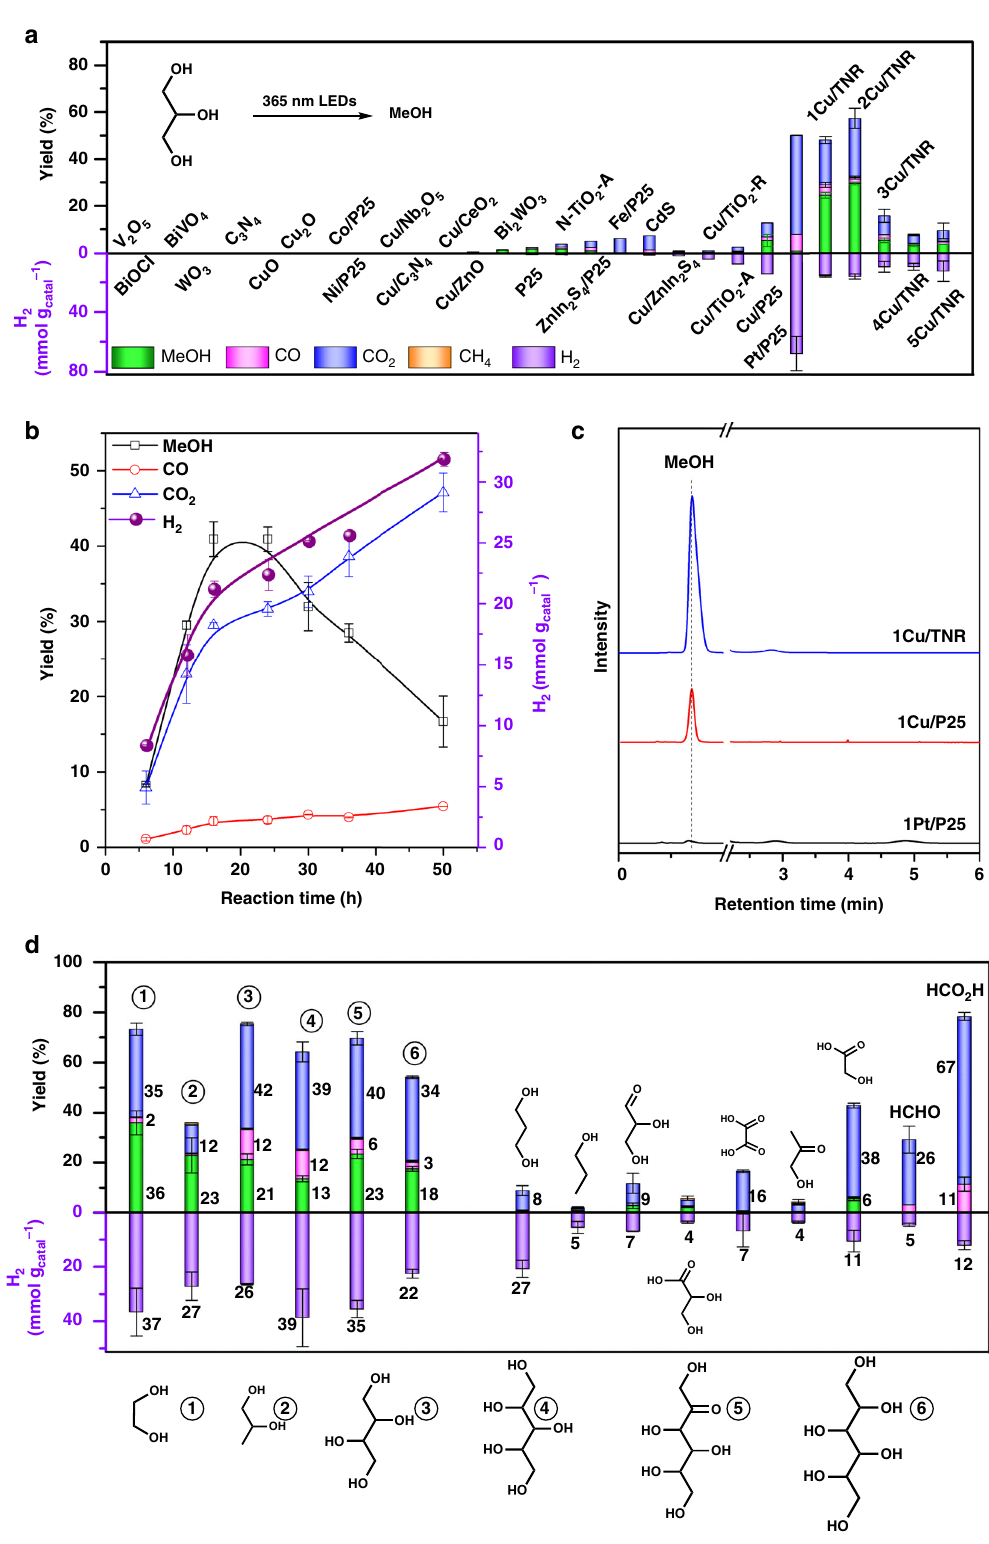
Fig. 2 Conversion of biomass resources to methanol. a Catalyst screening. Reaction conditions: 10 mg of glycerol, 10 mg of catalyst, 0.8 mL of MeCN, 0.2 mL of water, 365 nm LED (18 W, 55 mW cm − 2 ) irradiation for 12 h. b The effect of reaction time. c GC curves of liquid phase products. d Photo- reforming of different oxygenates. Detailed reaction conditions and product analysis are presented in Supplementary Tables 2, 3. Error bar represents the standard